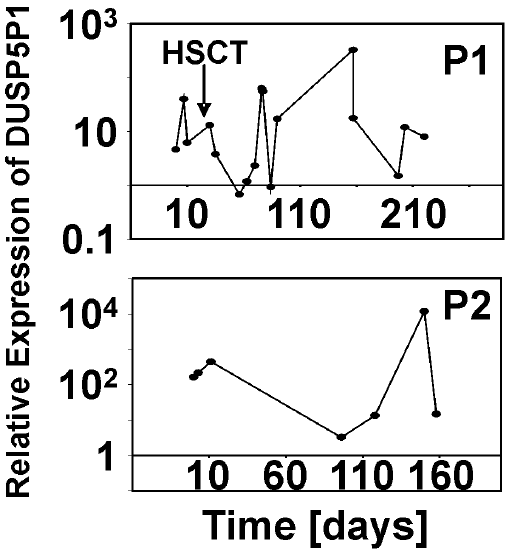
Figure 7. Time course of DUSP5P1 expression in the blood of refractory HL patients. Quantitative RT-PCR was used for determi- nation of expression of DUSP5P1 in PBMCs from two HL patients (P1 and P2). The date of first sampling was set as time point 0. For calculation of relative expression values, GAPDH was used as housekeeping control and the mean D ct value from 5 PBMC samples from healthy donors was set as 1. Patient # 1 was treated with hematopoietic stem cell transplantation (HSCT) at the indicated time point.